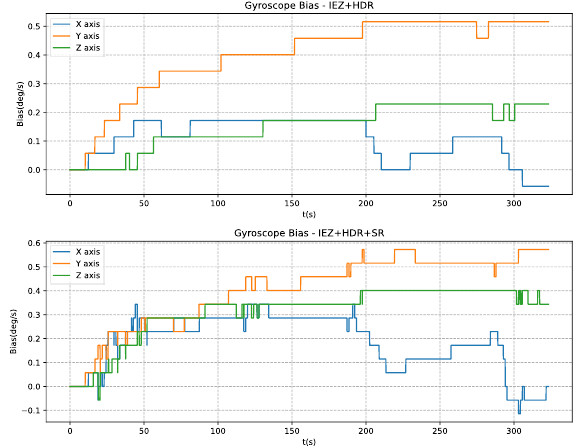
Figure 12 . Estimation of gyro bias (Experiment